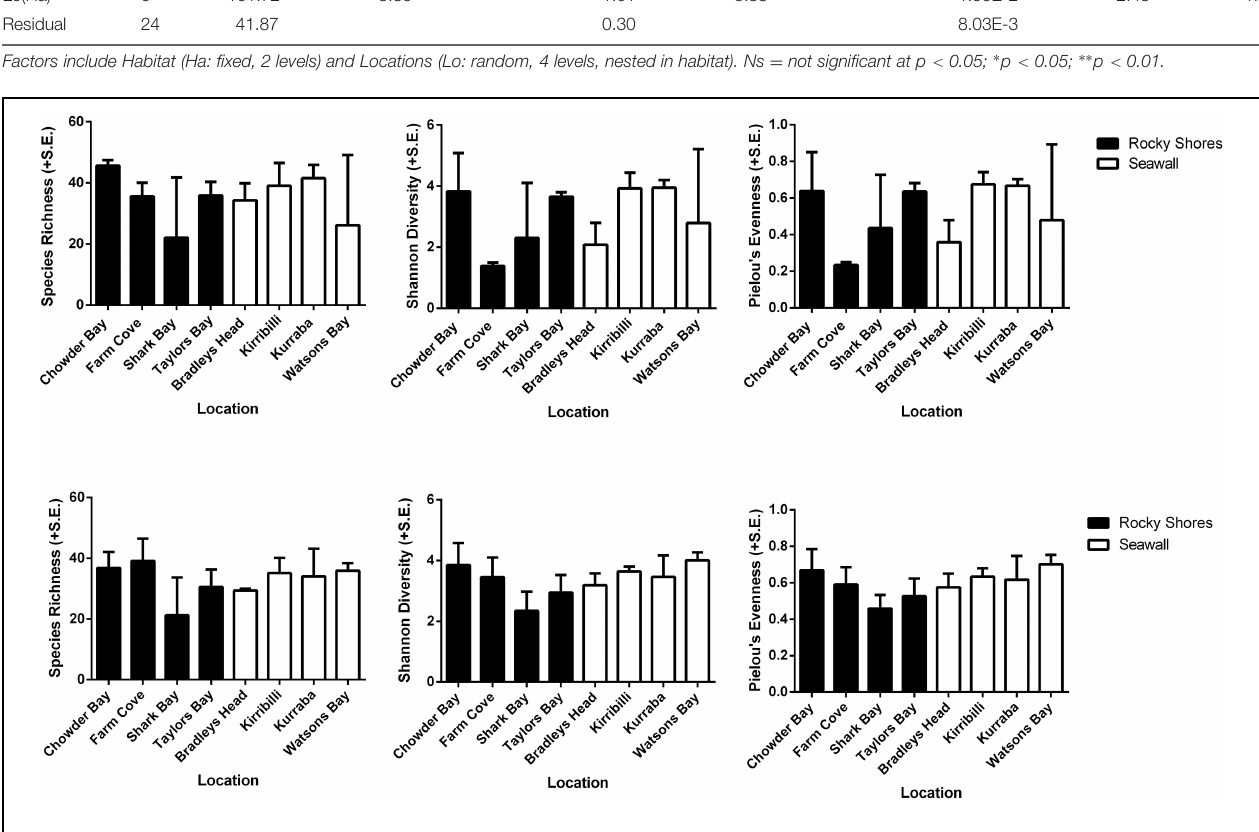
FIGURE 5 | Species richness, Shannon’s diversity and Pielou’s evenness analyzed from rarefied datasets of plots (Top) and recruitment blocks